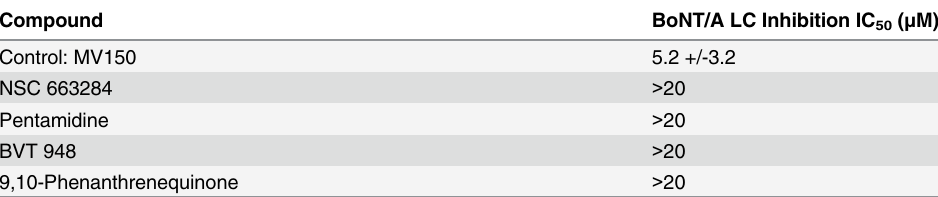
Table 1. Phosphatase inhibitors act on host cellular processes.